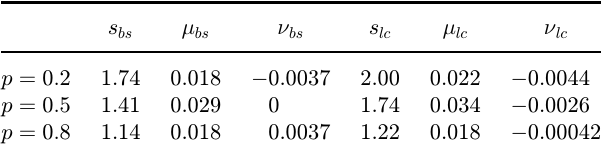
Table 5. Parameters of the distribution of erythrocytes in shape in a shear °ow with the shear rate of 660.2 s (cid:4) 1 , and level of light intensity at the isointensity line equal to 220 (in units of Fig. 6). The normalized light intensity at the isointensity line f ¼ 0 : 033. The number \ p " stands for the proportion of non- 0 deformable red blood cells in a sample of blood. The experiment was performed with the blood of rat 3.